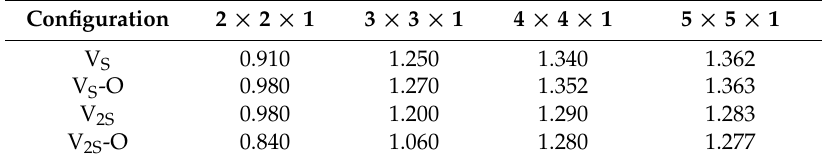
Table 3. The band gap size of a WS 2 monolayer with V S , and V 2S types of vacancy and after 1-O doping above two defective cases (denoted by V S -O and V 2S -O; The V X -O (X = S, 2S) means 1-O atom doped WS 2 monolayer with V X types of vacancy defects.) in different size supercells. The unit is eV.